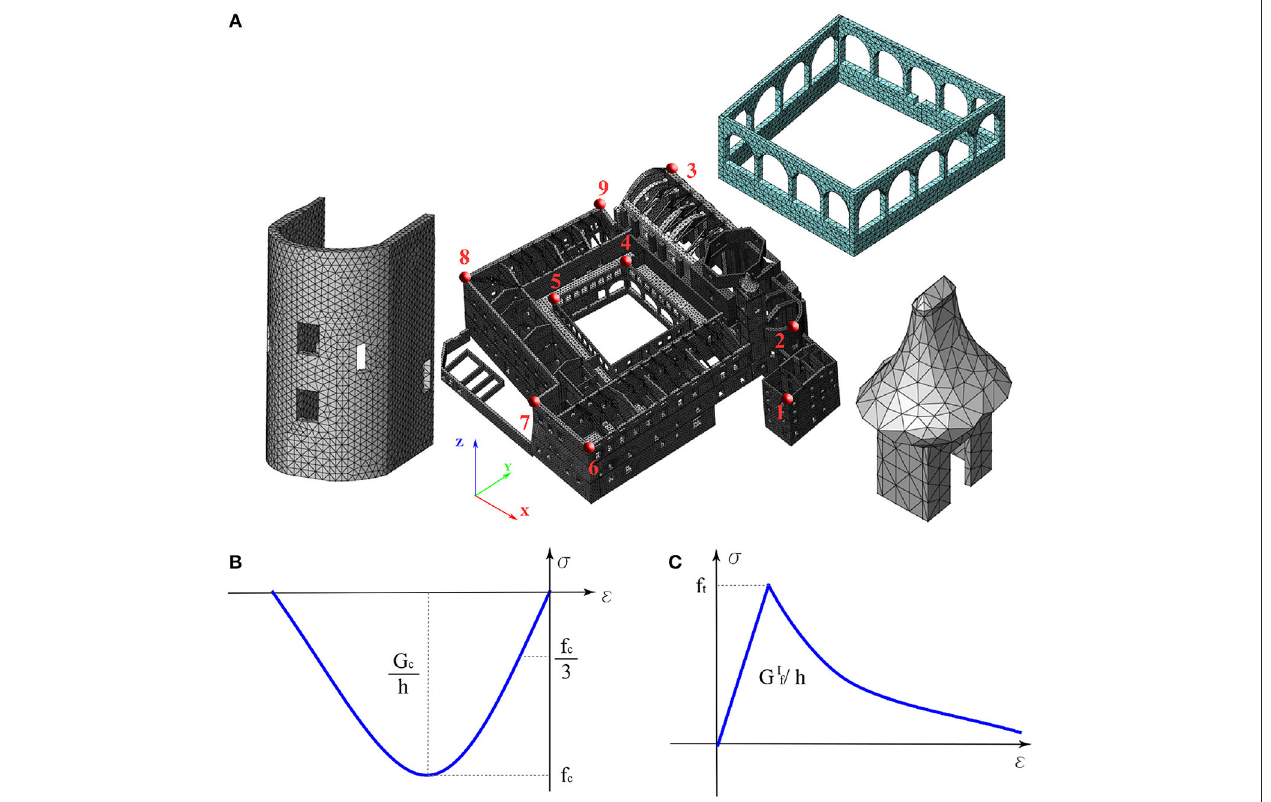
FIGURE 4 | Finite elements model of “Sant‘Agostino’s Sanctuary” in Offida (Central Italy) (A) , stress–strain constitutive relations used for the simulation for masonry uniaxial compression (B) , masonry uniaxial tension (C) .